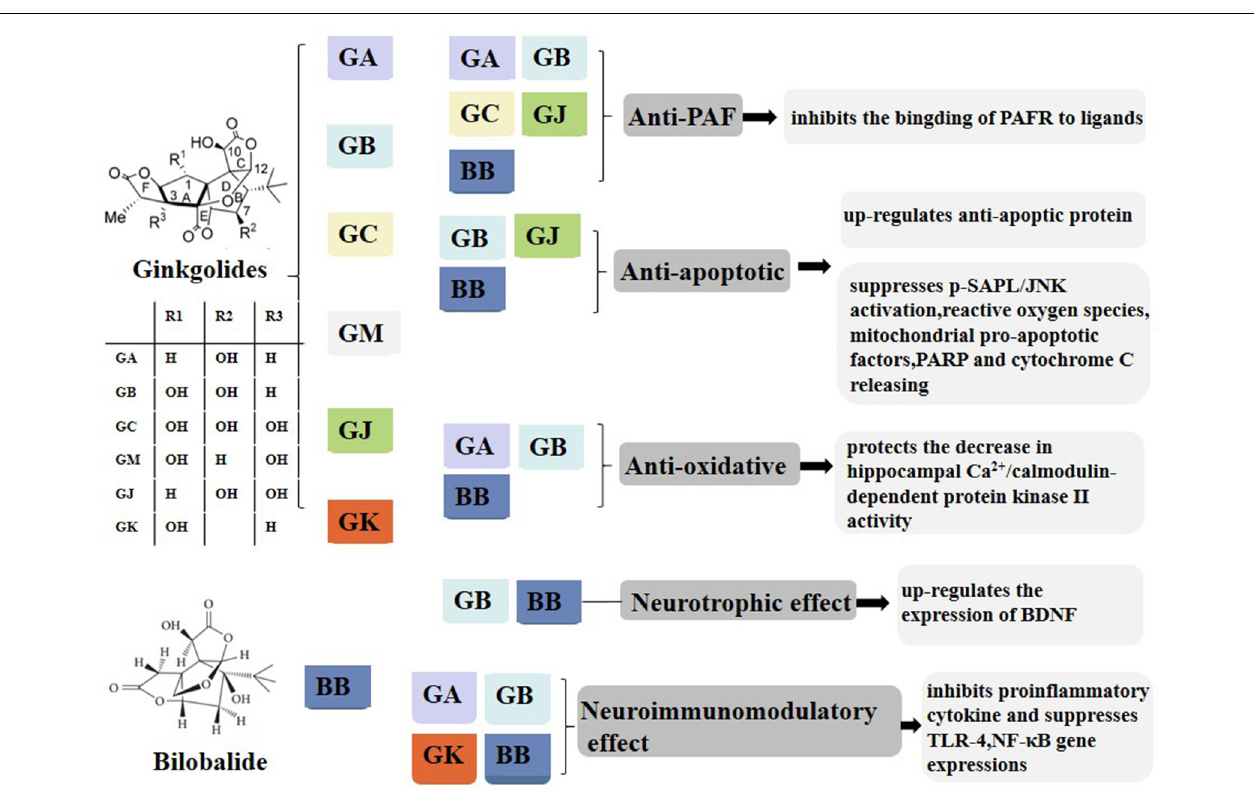
FIGURE 1 | Composition and pharmacological properties of ginkgolides. Ginkgolides are isolated and purified from the leaves of Ginkgo biloba . The ginkgo leaf extracts commonly contain flavonoids such as quercetin, kaempferol, myricetin, and terpene trilactone. The extracted terpene trilactone include ginkgolide A (GA), B, C, M, J, and K and bilobalide (BB). Ginkgolides have anti-PAF, anti-apoptotic, anti-oxidative, neurotrophic, and neuroimmunomodulatory effects. GA, ginkgolides A; BB, bilobalide; PAF, platelet-activating factor; PAFR, platelet-activating factor receptor; p-SAPK/JNK, phospho-stress-activated protein kinase/c-Jun N-terminal kinase; PARP, poly (ADP-ribose) polymerase; BDNF, brain-derived neurotrophic factor; TLR4, toll-like receptor-4; NF- κ B, nuclear factor-kappa